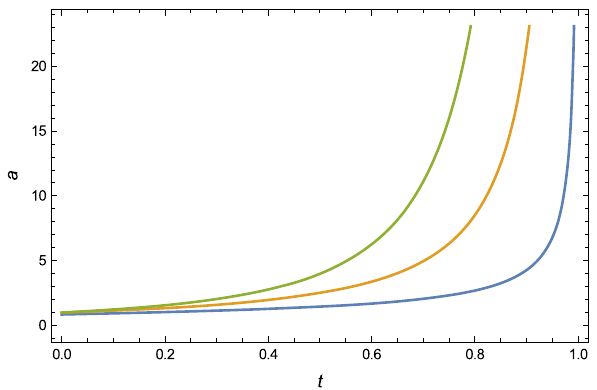
Fig. 17 Evolution of scale factor with respect to cosmic time. The various colors take on the following values of m . Blue: m = 3, green: m = 0 . 5, yellow: m = − 1 .